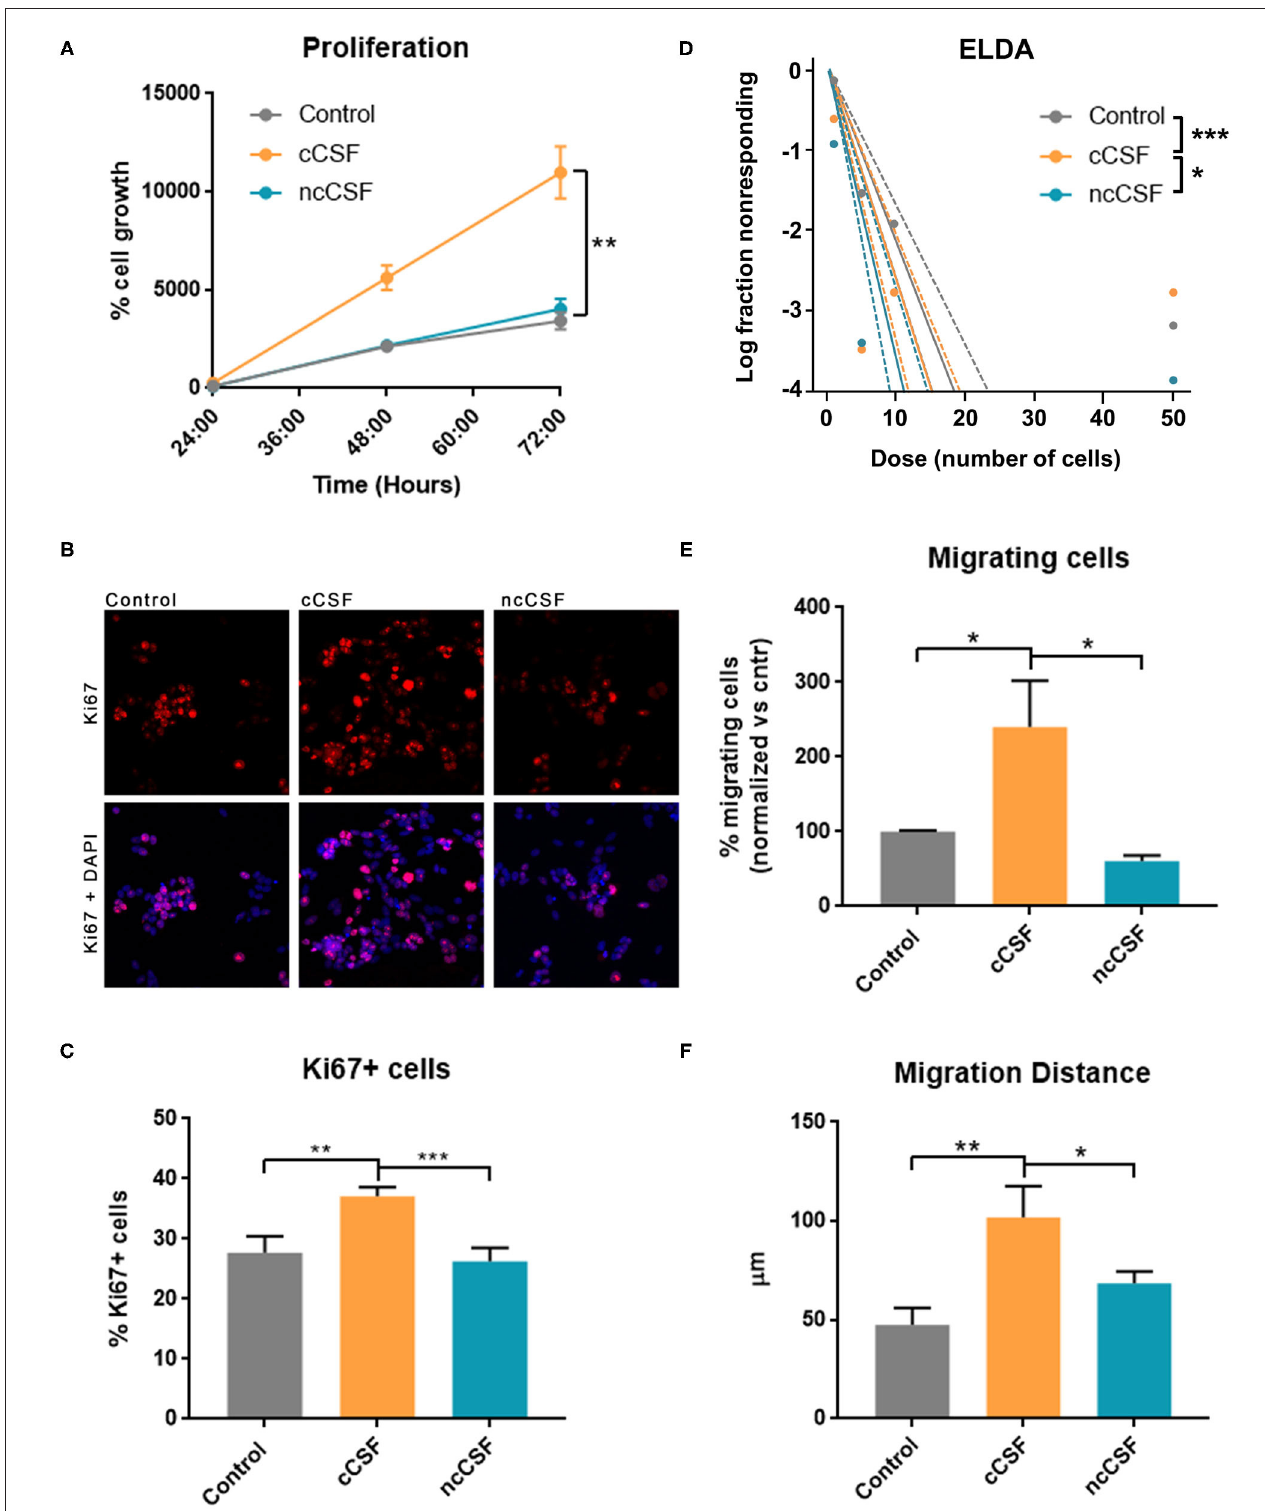
FIGURE 4 | CSF derived from GBM patients induces an increase in BTIC proliferation and migration in vitro . GBM cells were treated for 24h with either glioma derived CSF (cCSF) or non-cancer (ncCSF). After incubation time cells were processed for analysis. (A) Alamar blue assay tracked cells proliferation over time (graph shows growth between 24 and 72h post-treatment) revealing an increase proliferation rate in the cCSF treatment group (CSF pairs: